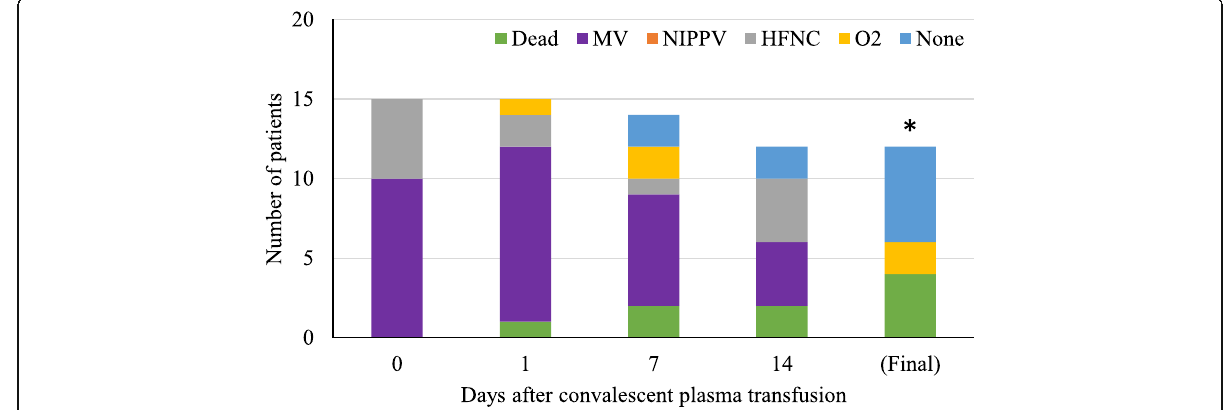
Fig. 1 Legend: Inpatient respiratory support type by hospital day among COVID-19 patients with life-threatening disease receiving convalescent plasma (n = 15). The asterisk (*) marks that three patients were excluded from the tally because their final respiratory status is not known. At the time of last follow-up, two were on mechanical ventilation and one was on high-flow nasal